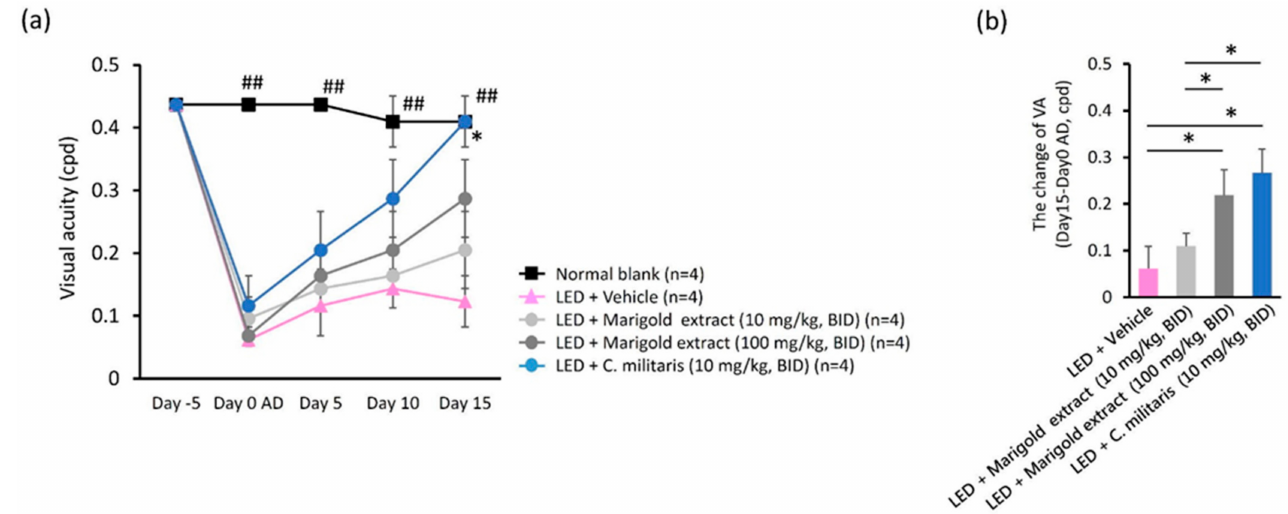
Figure 3. Effects on visual acuity (VA) of C. militaris extract treatment. ( a ) Changes in VA threshold after light-evoked retinal photodamage; ( b ) restorative efficacy of VA threshold of water-soluble carotenoid-rich, C. militaris extract-treated and lutein-rich, marigold extract-treated mice. Data are expressed as mean ± SE. A Mann–Whitney U test was performed; ## : p < 0.01, *: p <